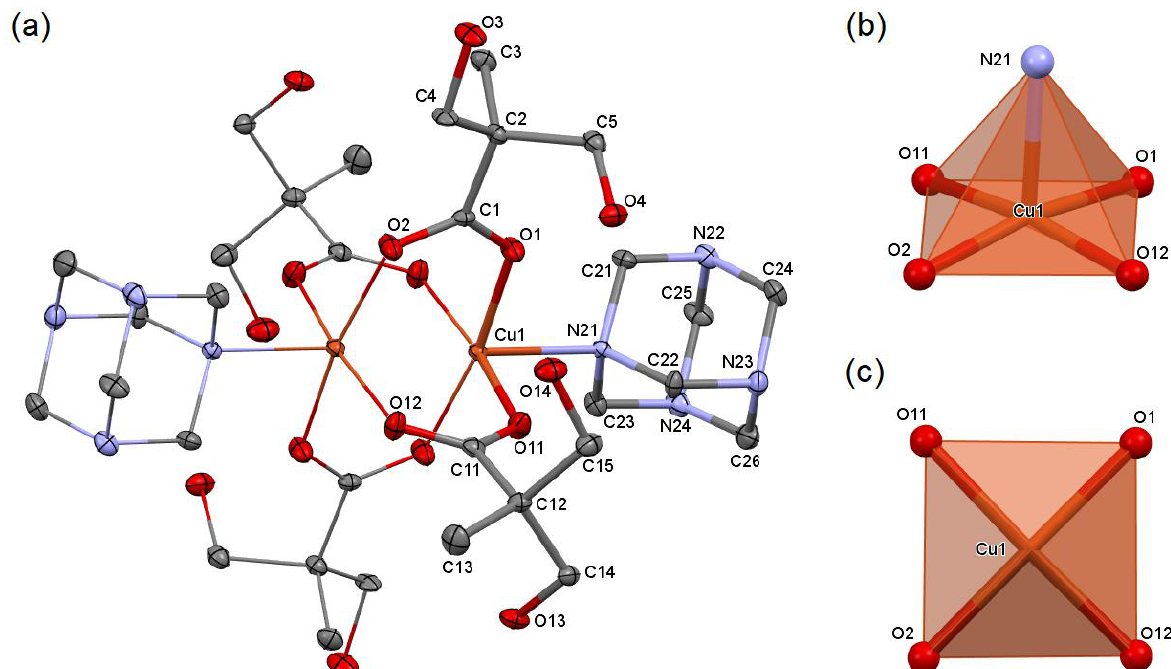
Figure 2. Molecular structure of 2, plotted with a 50% probability of displacement ellipsoids of nonhydrogen atoms ( a ). The equivalent atoms (without labels) were generated according to transformation: − x + 1, − y + 1, − z + 1. Hydrogen atoms were omitted for clarity. Coordination polyhedron of 2, general view ( b ), tetragonal base ( c ).